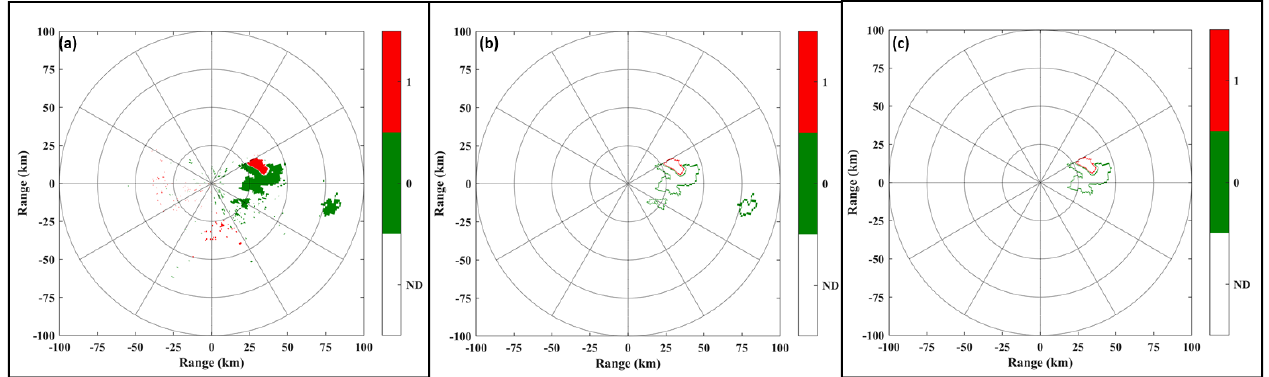
Figure 12 Figure 12. Eight-Neighborhood method positive and negative velocity connected region matching. ( a ) Radial velocity binarization, ( b ) Eight-Neighborhood method edge detection, and ( c ) positive and negative velocity pair matching results. In the figure, red and green indicate positive and negative velocities.